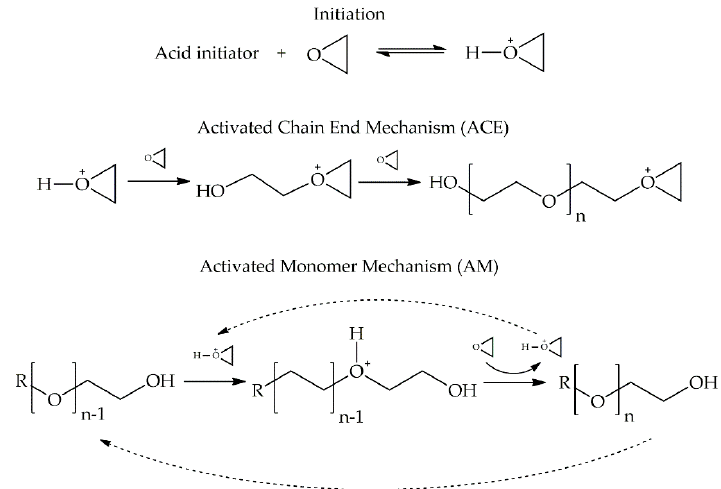
Figure 1. The mechanisms of the ring-opening cationic polymerization of epoxy in the presence of alcohol: the activated chain end (ACE) and the activated monomer (AM) mechanisms [6] .